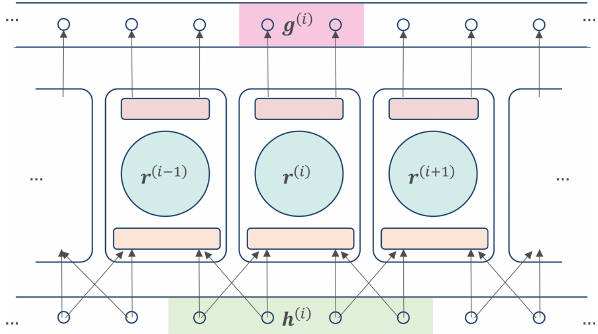
Figure 2. The conceptual diagram of parallelized reservoir comput- ing architecture. The state space is separated into some groups and the same number of reservoirs are shown parallel. Each reservoir group accepts the inputs from the corresponding group and some adjacent grids and predict the dynamics of the corresponding group.